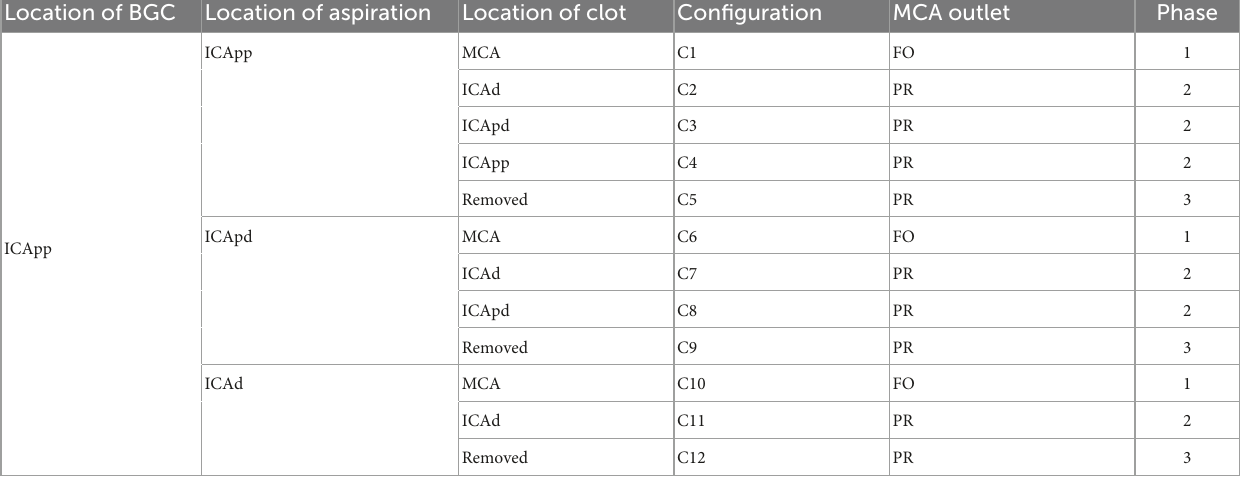
TABLE 3 Network configurations for simulations of mechanical thrombectomy.